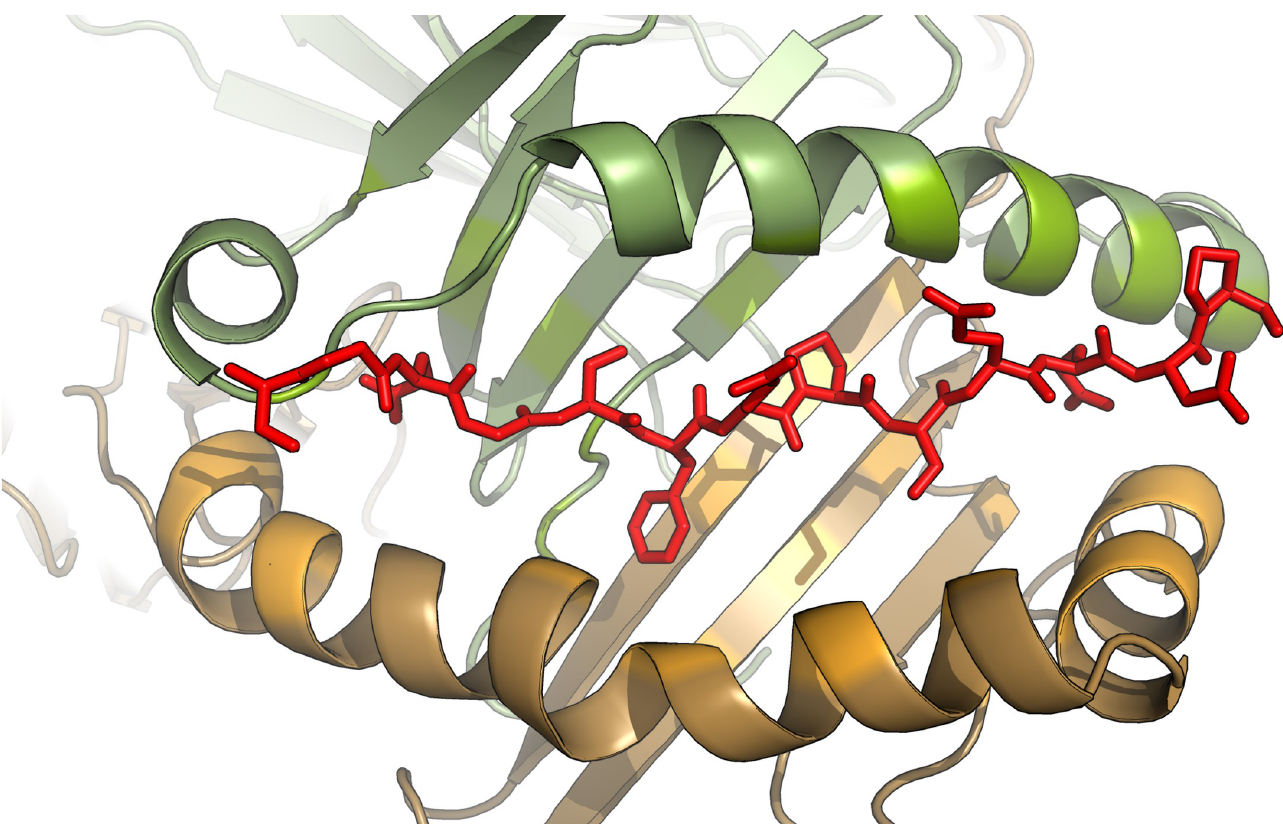
Fig 1. MHC class II molecules are heterodimers consisting of α (green) and β (orange) chains. The antigen binding groove is formed by two alpha-helices above a beta-sheet floor. Antigens (red) fit in the cleft and stabilized by electrostatic interactions and/or hydrogen bonds to anchor peptides of the groove (regions with light shades). The structure being illustrated is based on the structure with PDB ID: 2NNA